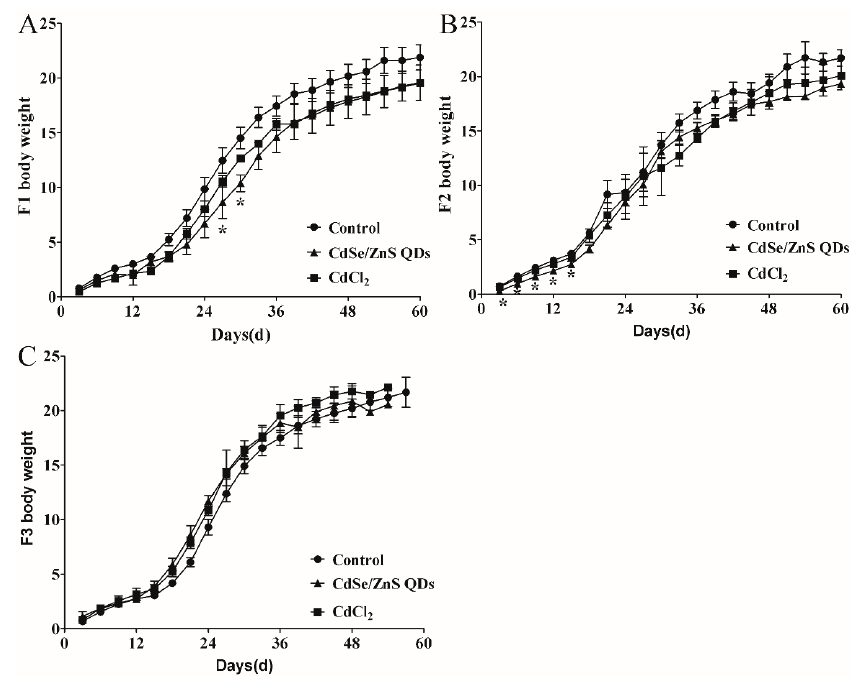
Figure 7. 60-day body weight growth ratios: ( A ) F1 (n = 6); ( B ) F2 (n = 6); ( C ) F3 (n = 6). All the data are expressed as mean ± SD. * p < 0.05 vs. control. The body weight growth ratios = (bodyweight − body weight in PND1)/body weight in